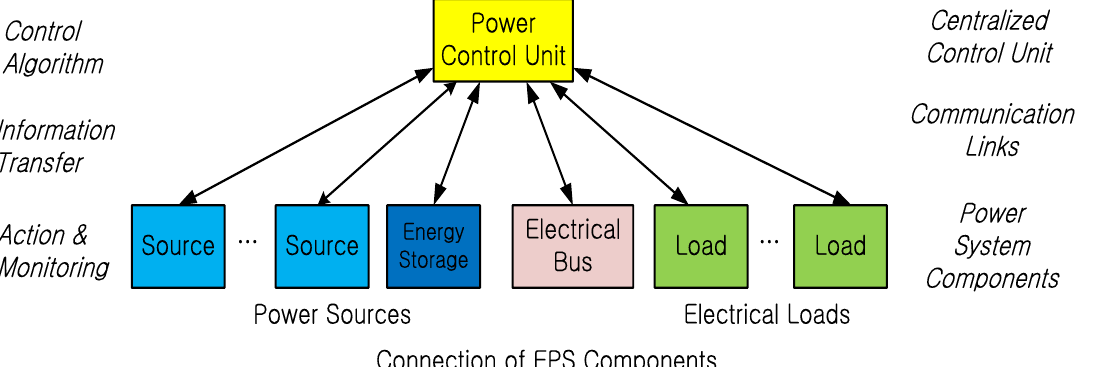
Figure 4. Centralized control architecture for an aircraft EPS.